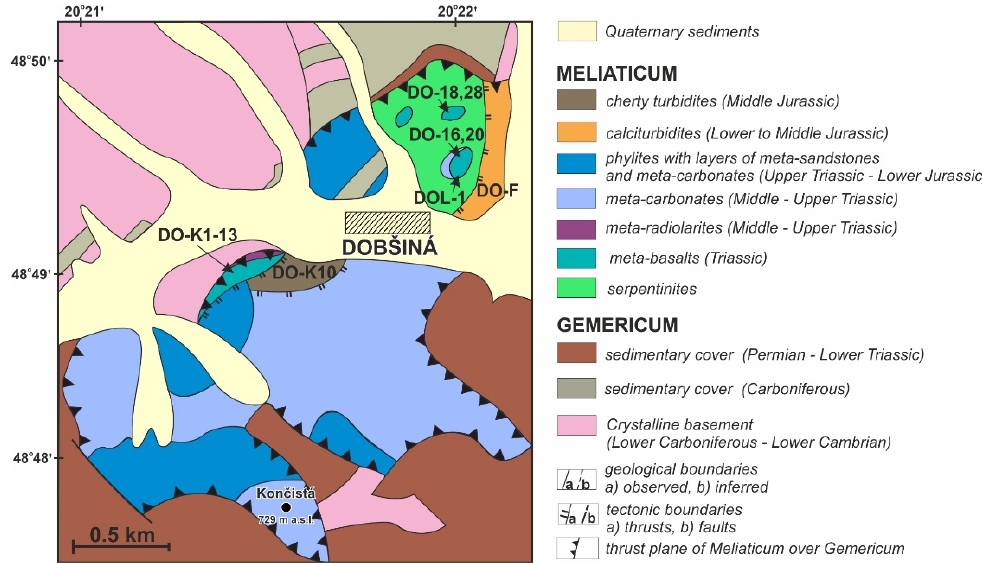
Figure 3. Schematic geological map from Dobšiná area (modified from [44]) with sample location.